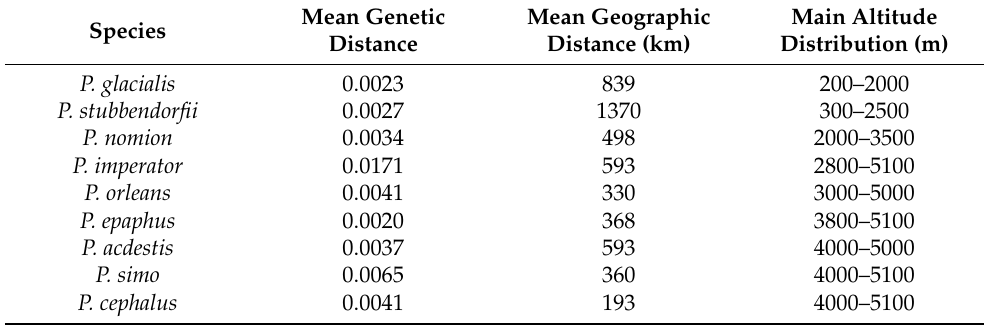
Table 2. Mean intraspecific geographic and Nei’s genetic distances of the Parnassius species. Mean Species